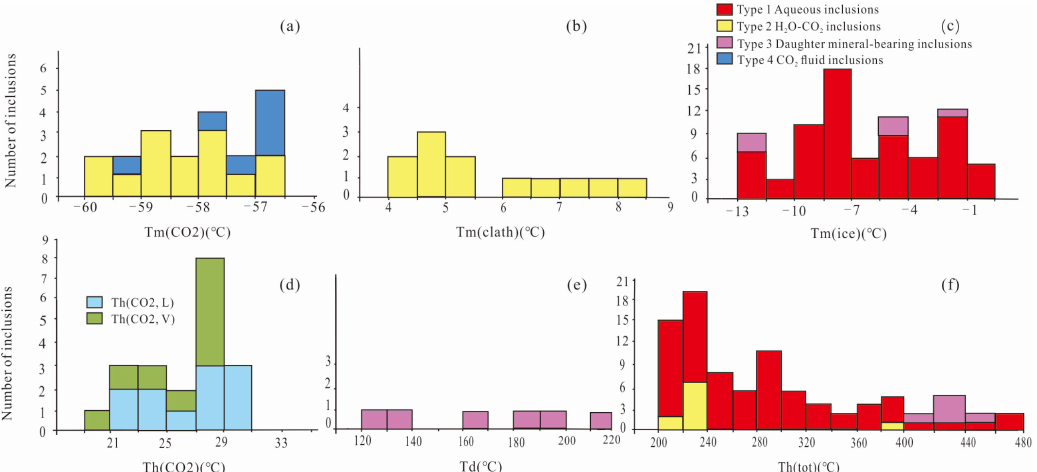
Figure 6. Histograms of microthermometric data including: ( a ) melting temperatures of CO2 (Tm(CO2)), ( b ) clathrate-melting temperatures (Tm(clath)), ( c ) final ice melting temperatures (Tm(ice)), ( d ) homogenization temperatures of CO2 (Th(CO2)), ( e ) dissolution temperatures of halite/sylvite (Td), and ( f ) temperatures of total homogenization